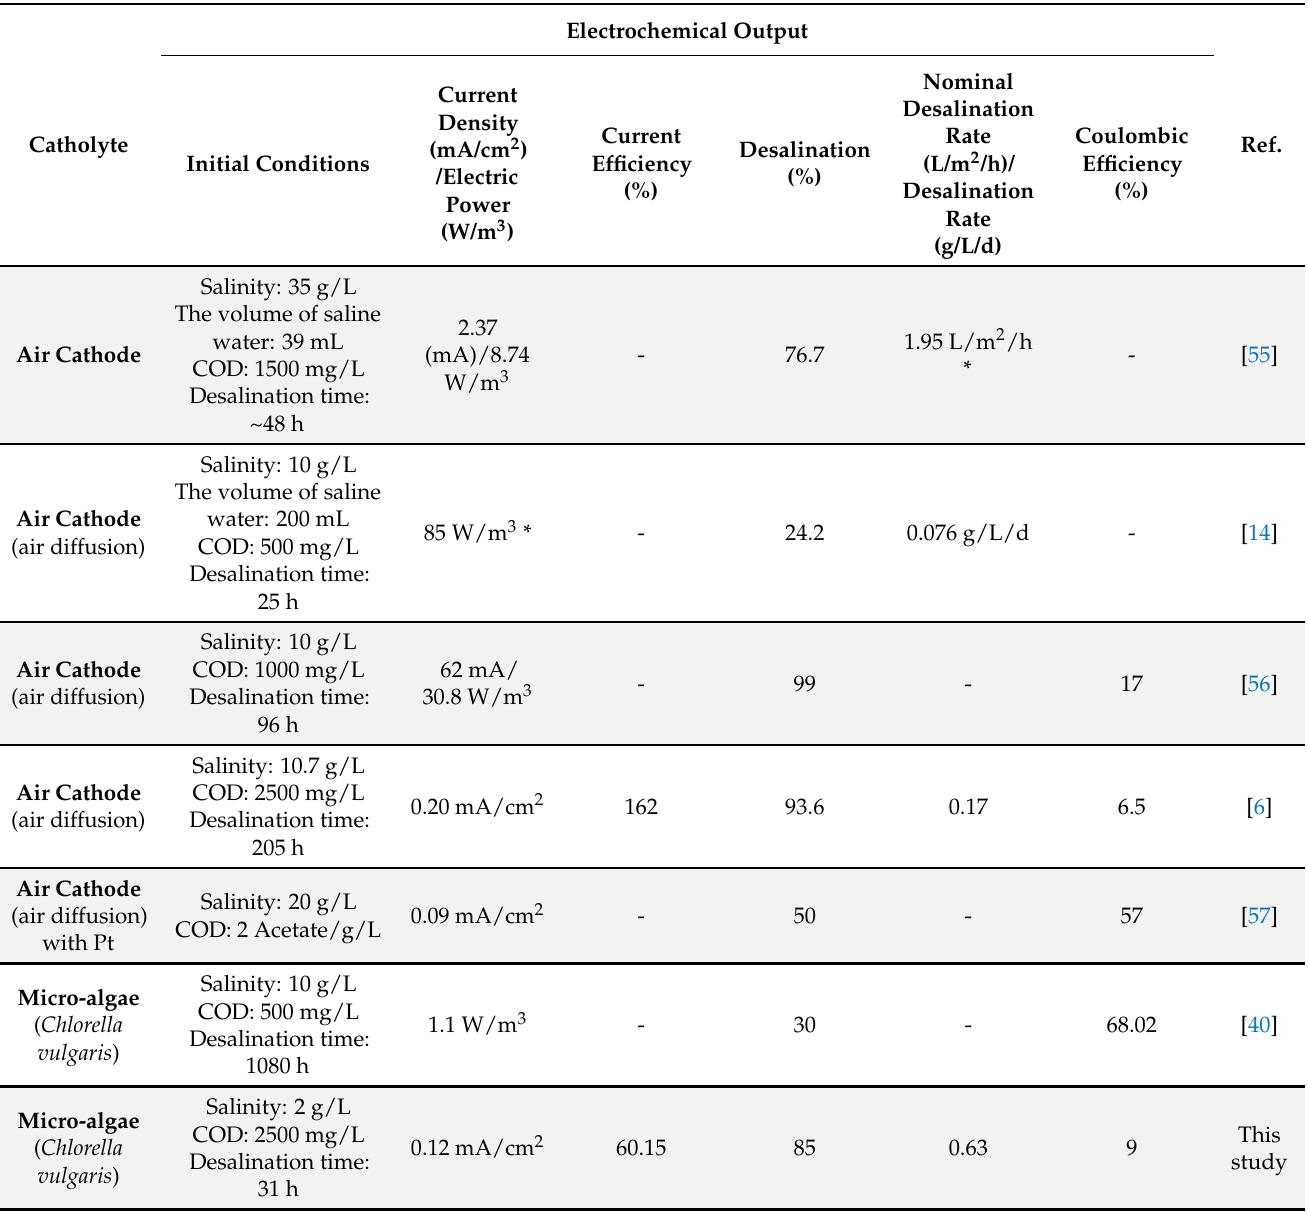
Table 4. Electrochemical performance of cathode